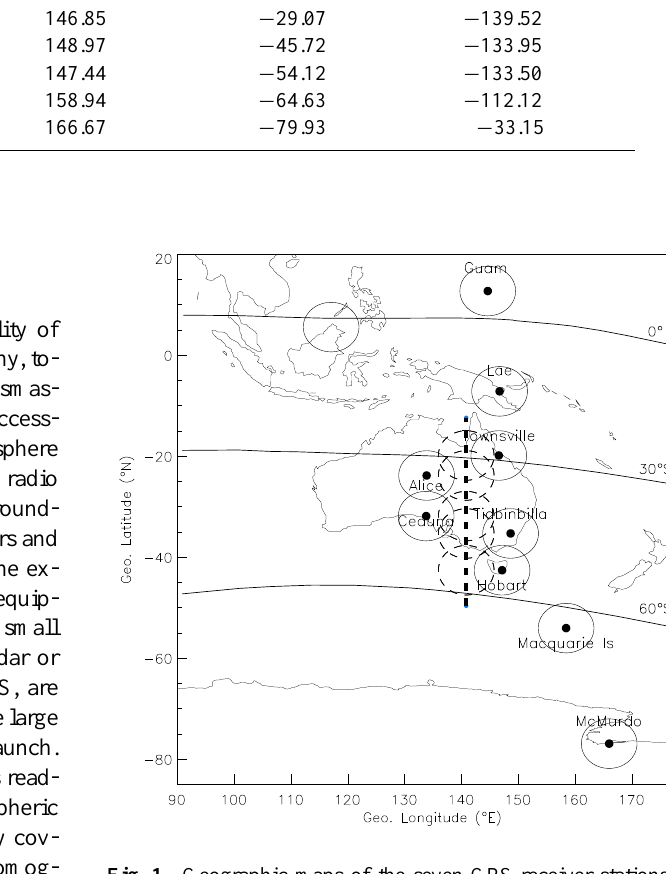
Fig. 1. Geographic maps of the seven GPS receiver stations that provided data for this study. The circles in each station depict the field of view (25 ◦ elevation). The three horizontal curves depict the geomagnetic latitude axis at 0 ◦ , 30 ◦ S and 60 ◦ S, respectively, from top to